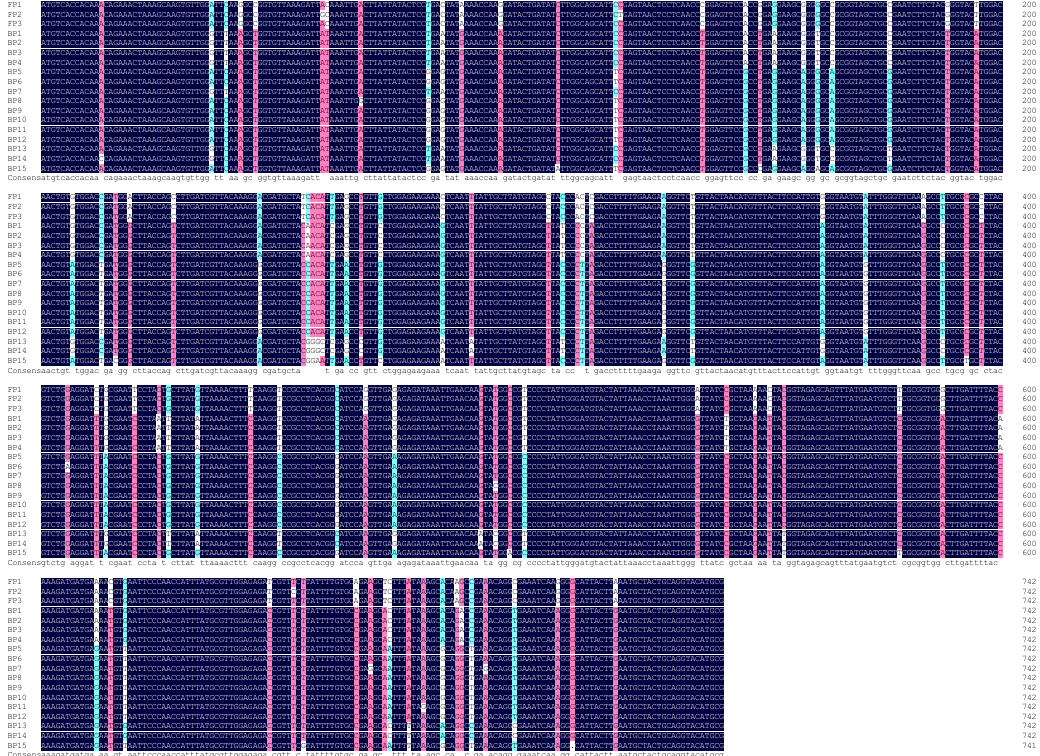
Figure 3. Alignment of rbcL genes in BP and FP. BP, bee pollen—pollen collected from the corbiculae of A. mellifera ; FP, flower pollen—pollen collected from the